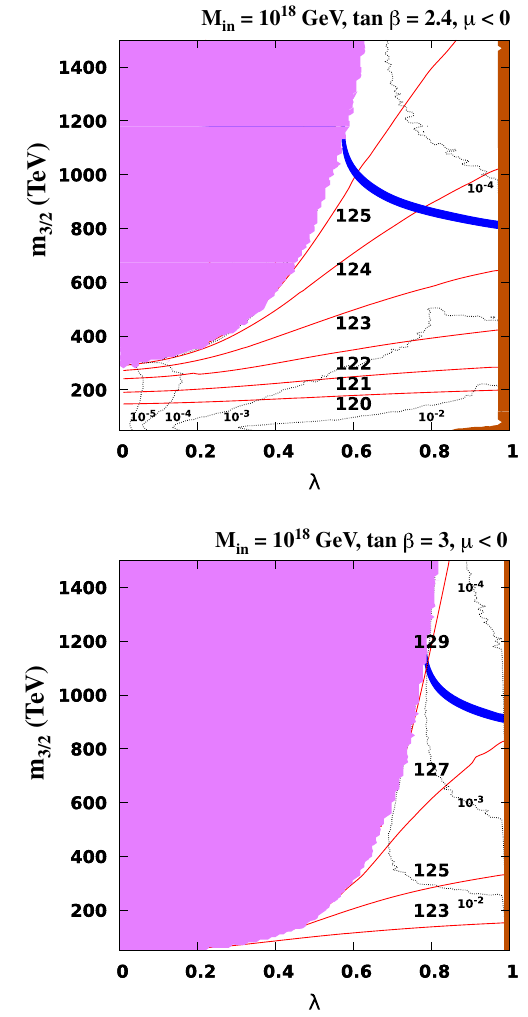
Fig. 2 Examples of the λ - m 3 / 2 plane for M in = 10 18 GeV, and μ < 0. In the upper panel, tan β = 2 . 4 and in the lower panel, tan β = 3, The solid red and dotted black curves show the Higgs mass m h and λ (cid:7) , respectively. The blue shaded region corresponds to the areas where the LSP abundance agrees with the observed dark matter density. In the magenta region, rEWSB can not be obtained, while in the brown region λ becomes non-perturbative at the input scale